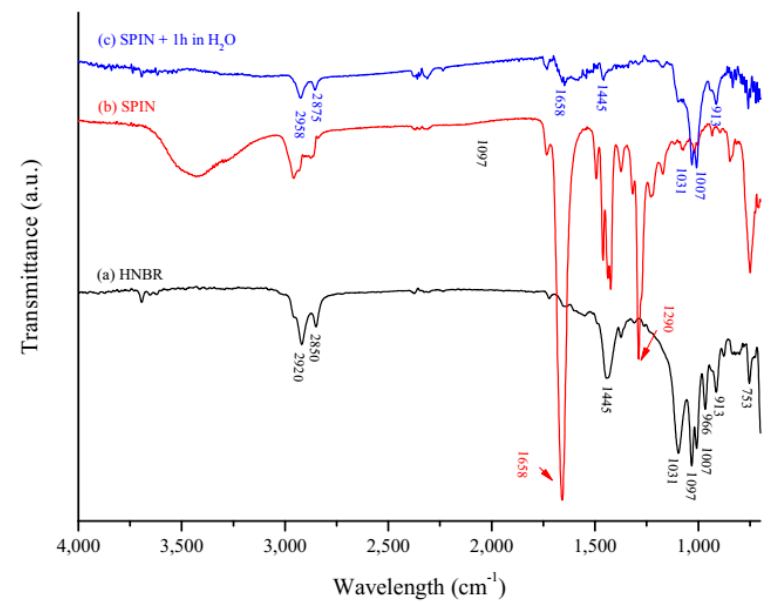
Figure 4. ATR-FTIR spectra of: ( a ) pristine HNBR, ( b ) HNBR after surface physical interpenetrating network (SPIN) functionalization and ( c ) HNBR after SPIN functionalization and immersion in distilled water for 1 h.